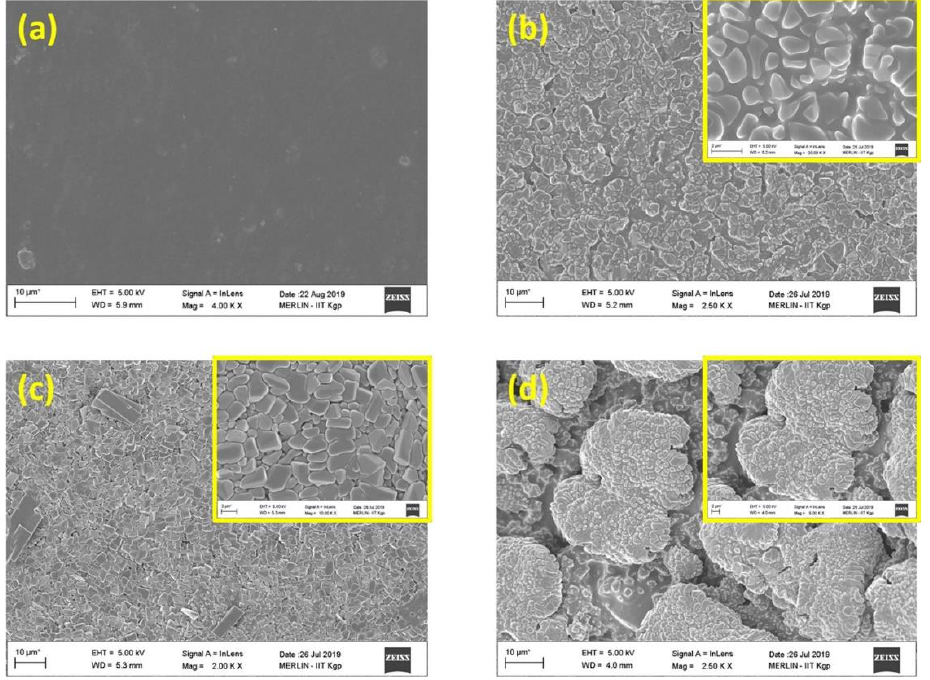
Figure 18. FE-SEM images of ( a ) native FENR, and FENR-POSSMI hybrids containing ( b ) FENR- POSSMI A, ( c ) FENR-POSSMI B and ( d ) FENR-POSSMI C (he ratio of furan groups to POSSMI, respectively, 27:1, 9:1, 3:1). Reprinted from Eur. Polym. J . 2021, 146 , Raut, S.K.; Mondal, P.; Parameswaran, B.; Sarkar, S.; Dey, P.; Gilbert, R.; Bhadra, S.; Naskar, K.; Nair, S.; Singha, N.K., Self-healable ultrahydrophobic modified bio-based elastomer using Diels-Alder ‘click chemistry’, 110204, [76]. Copyright (2021), with permission from Elsevier.